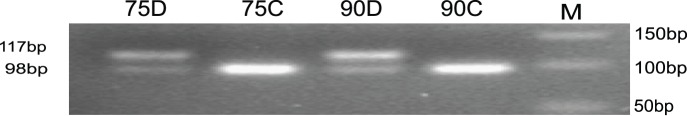
Biallelic status of the NNAT gene.PCR products from the genomic DNA (D) and cDNA (C) were digested with Hinf- I. Lanes from left to right are as follows: DNA on day75 of gestation, cDNA on day75 of gestation, DNA on day90 of gestation, cDNA on day90 of gestation, and the DL2000 marker.